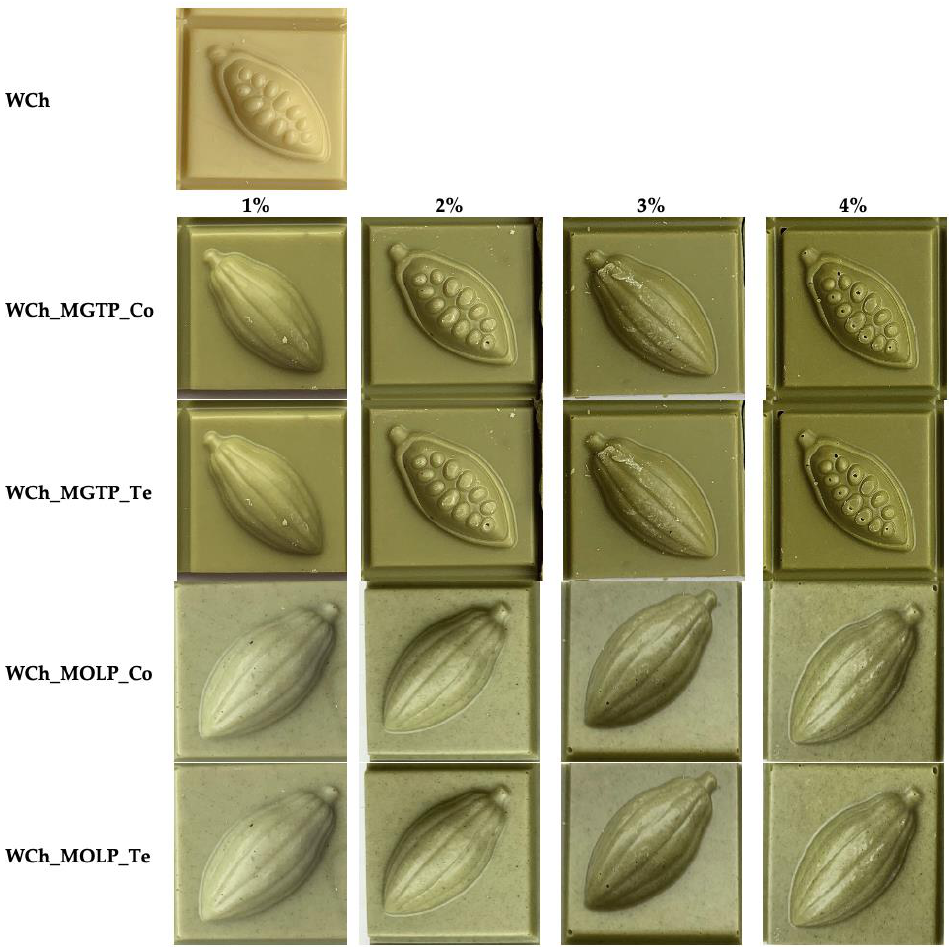
Figure 1. Photographs of white chocolate (WCh) samples without and with different amounts (1–4%) of matcha green tea powder (MGTP) and moringa leaf powder (MOLP) introduced during the conching (Co) and tempering (Te) processes.